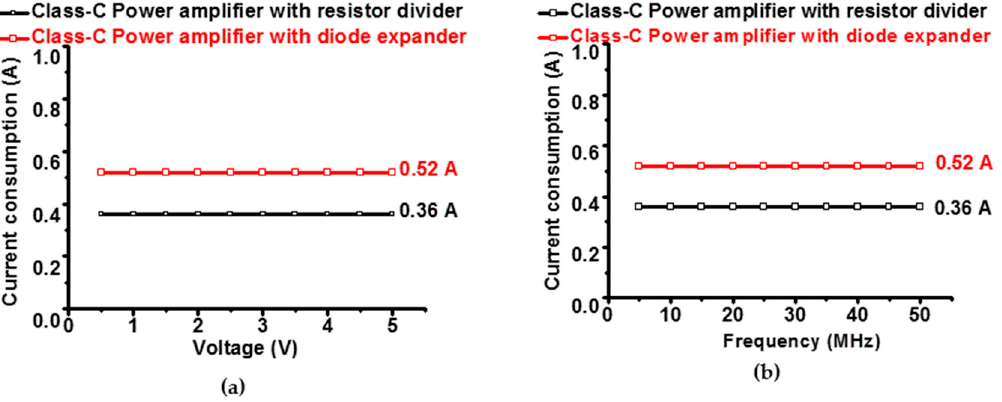
Figure 6. ( a ) Current consumptions of the class-C power amplifier versus input voltage and ( b ) frequency with the resistor divider and diode expander